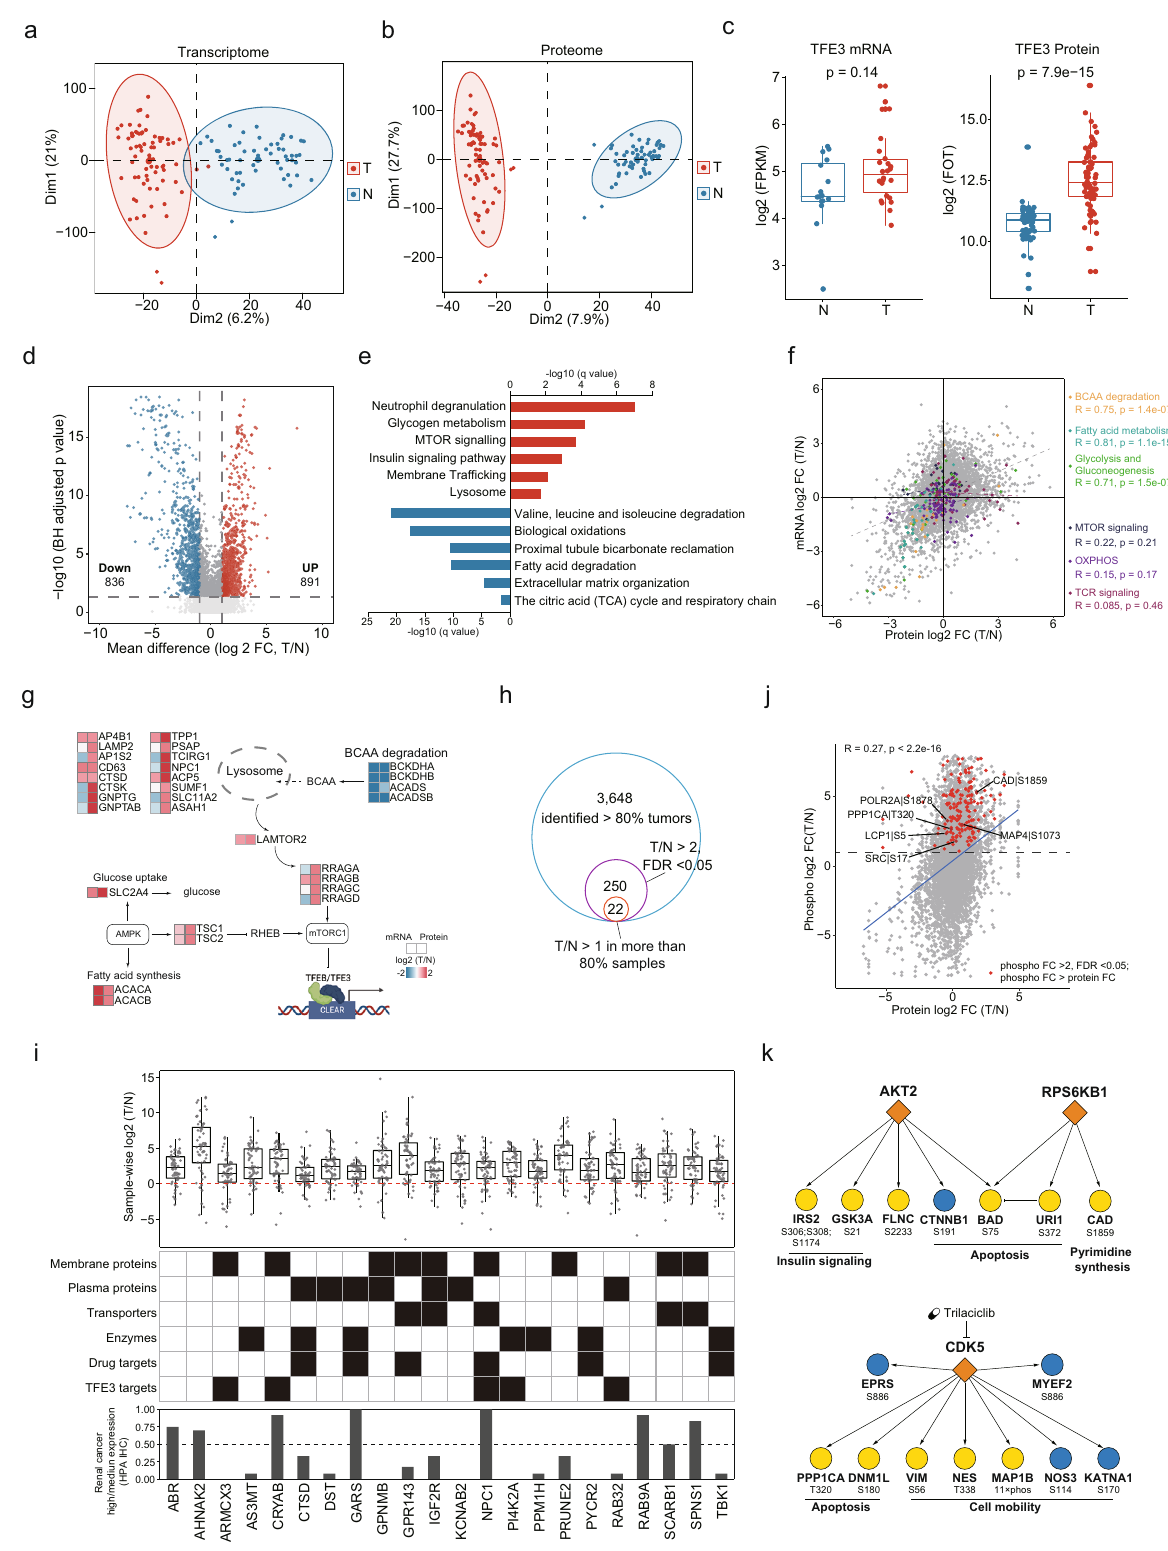
downregulated and 891 upregulated in tRCC tumors compared to adjacent tissues (Fig. 2d; Supplementary Data 4). Enrichment analysis revealed neutrophil degranulation, insulin signaling pathway, glyco- gen metabolism, membrane traf fi cking, mTOR signaling, and lysoso- mal function to be upregulated in tumors. Extracellular matrix organization, proximal tubule bicarbonate reclamation, and multiple